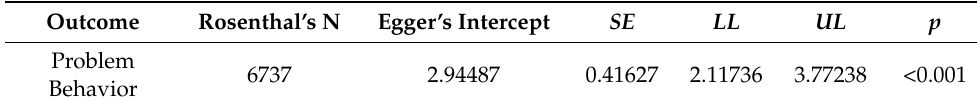
Figure 2. Funnel plot for research on problem behavior. Table 3. Results of publication bias test.